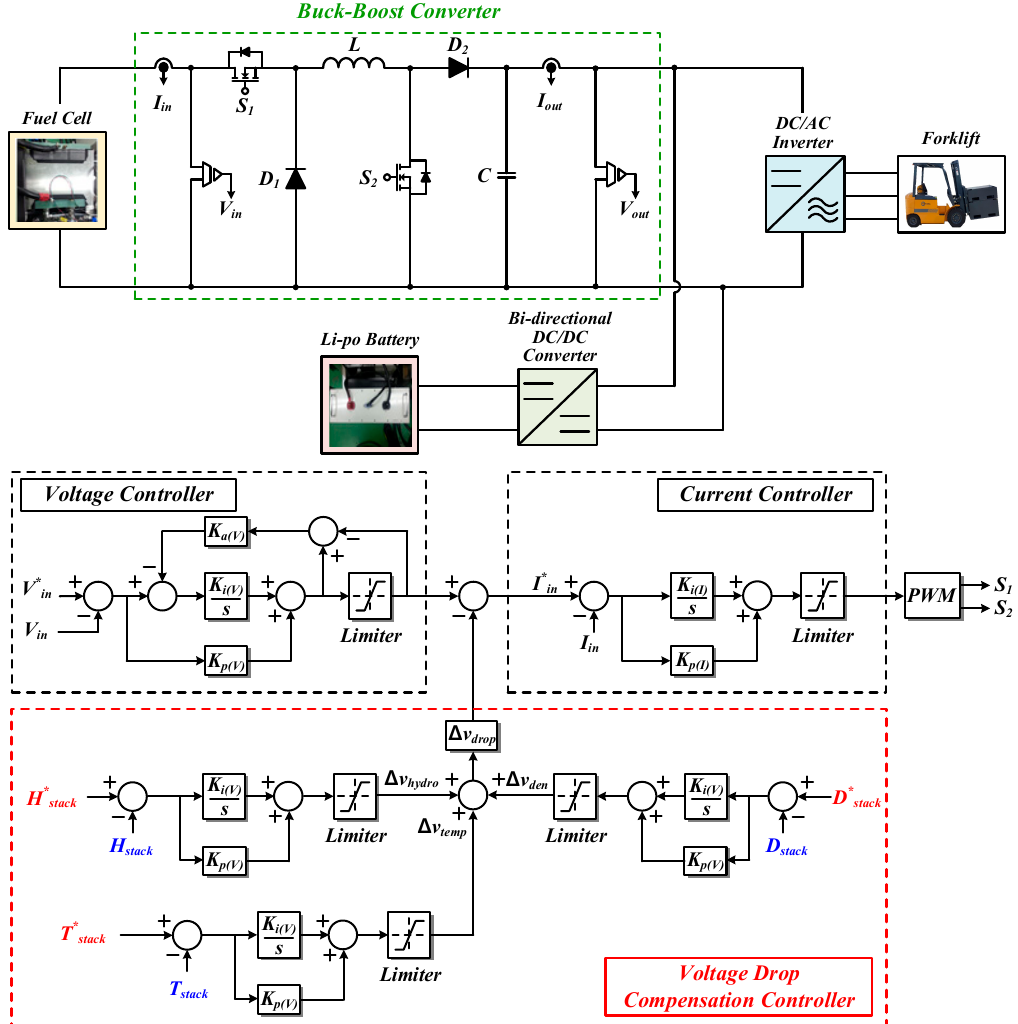
Figure 7. Control block diagram of the proposed voltage drop compensation method.